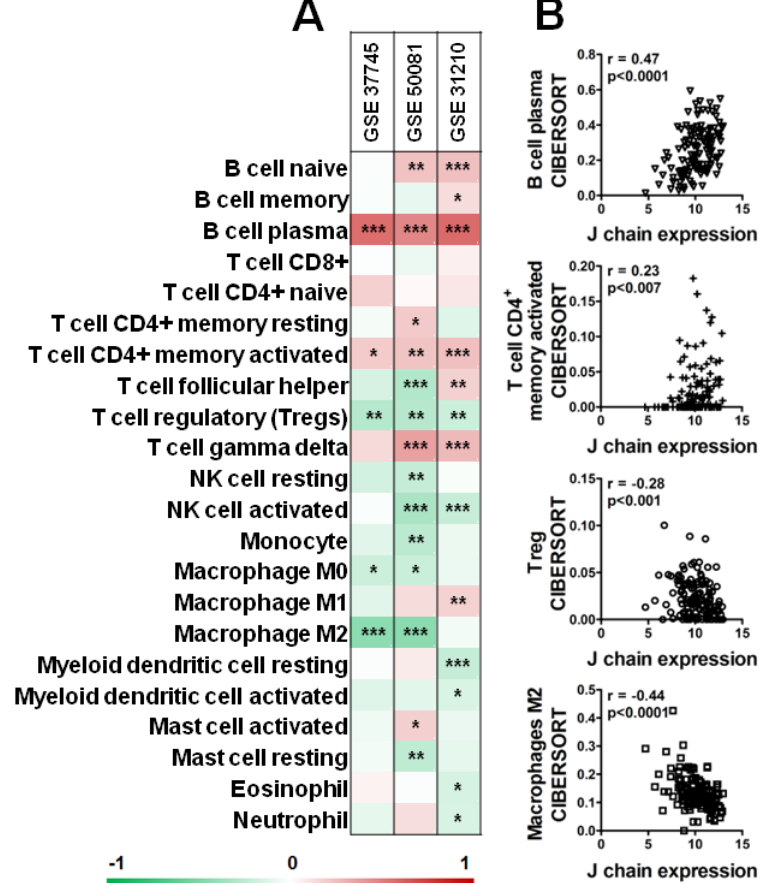
Figure 7. Correlation analysis of J chain expression and immune profile in lung adenocarcinoma patients. ( A ) Spearman correlation between J chain levels and relative fraction of 22 leukocyte subtypes (LM22 signature) as computed by CIBERSORT in adenocarcinoma samples of GSE37745 (n = 106), GSE50081 (n = 129), GSE31210 (n = 246) datasets. r of Spearman correlation is color-coded and relative significance is as follows: * p < 0.05, ** p < 0.01, *** p < 0.001. ( B ) Representative correlation plots in samples of the GSE50081 dataset between J chain expression and B plasma cells, CD4 + memory-activated T cells, Treg and M2 macrophages. r of Pearson and relative p -values are shown.